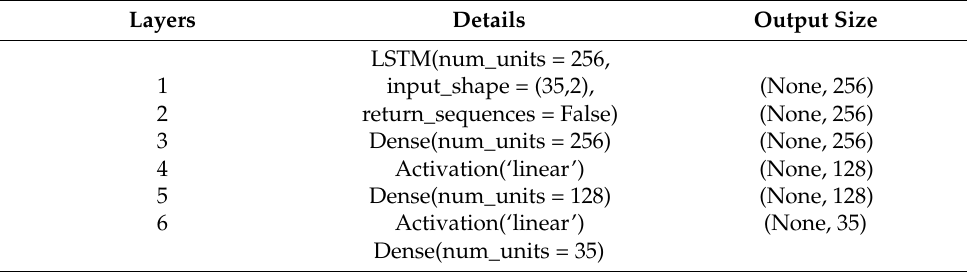
Figure 17. Car trajectory prediction model structure. Table 6. The parameters of the car trajectory prediction model structure.